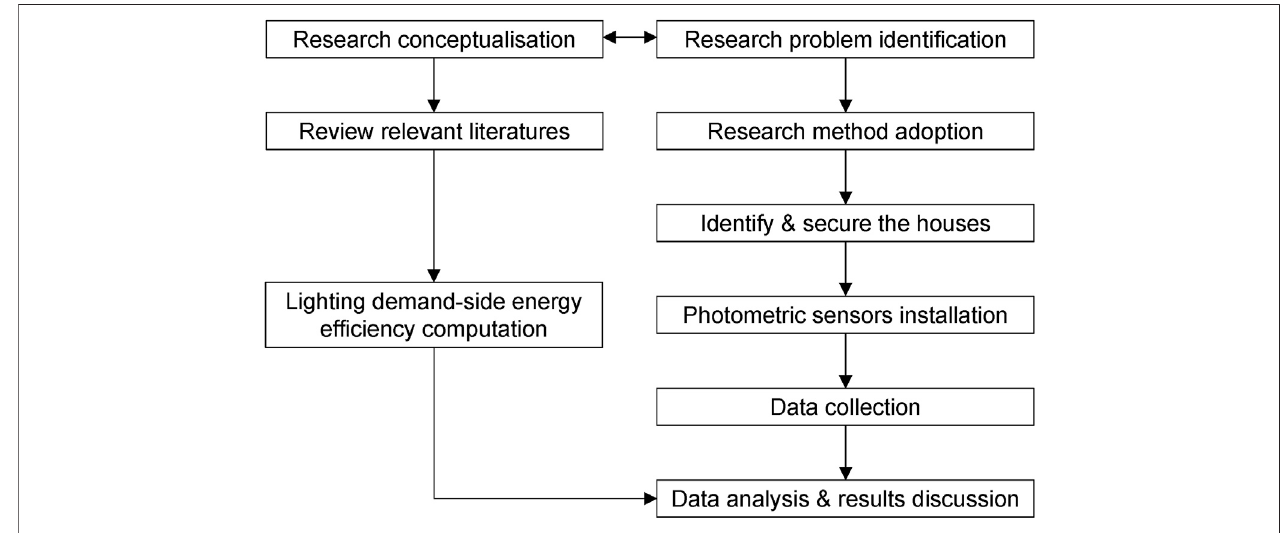
FIGURE 1 | Research method steps.